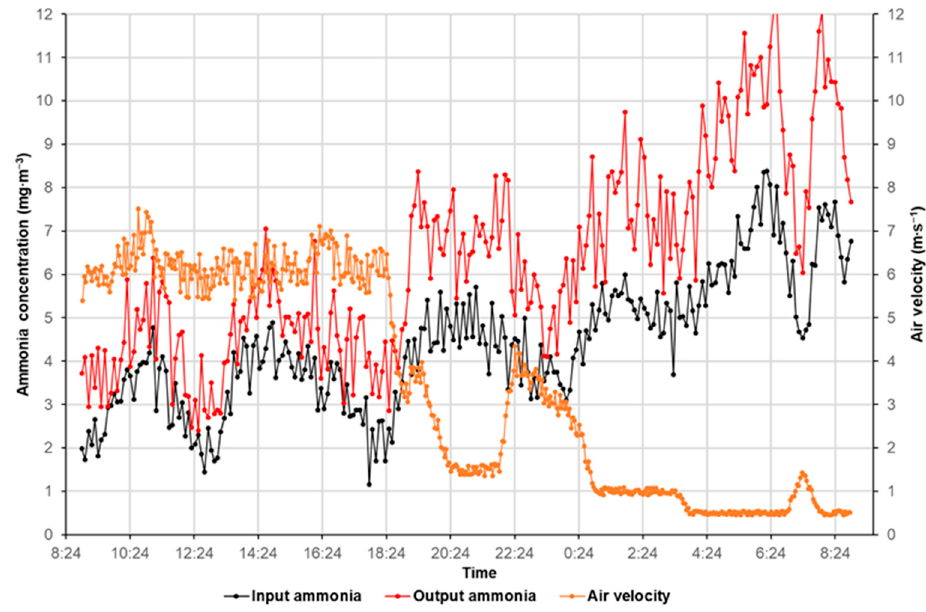
Figure 4. Creation of model values based on real data from the stable.